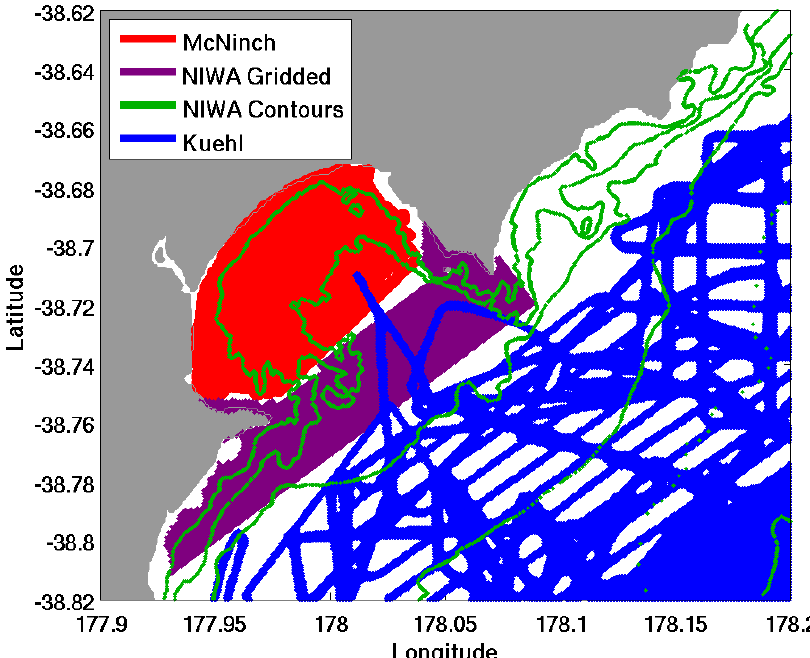
Figure 3. Coverage of bathymetric datasets near Poverty Bay mouth. Datasets are labeled by source (see Table 3). The National Institute of Water and Atmosphere (NIWA) contours also act as 10 m bathymetric contours. Note that the NIWA contours and multibeam data provided by S. Kuehl extend onto the continental shelf and